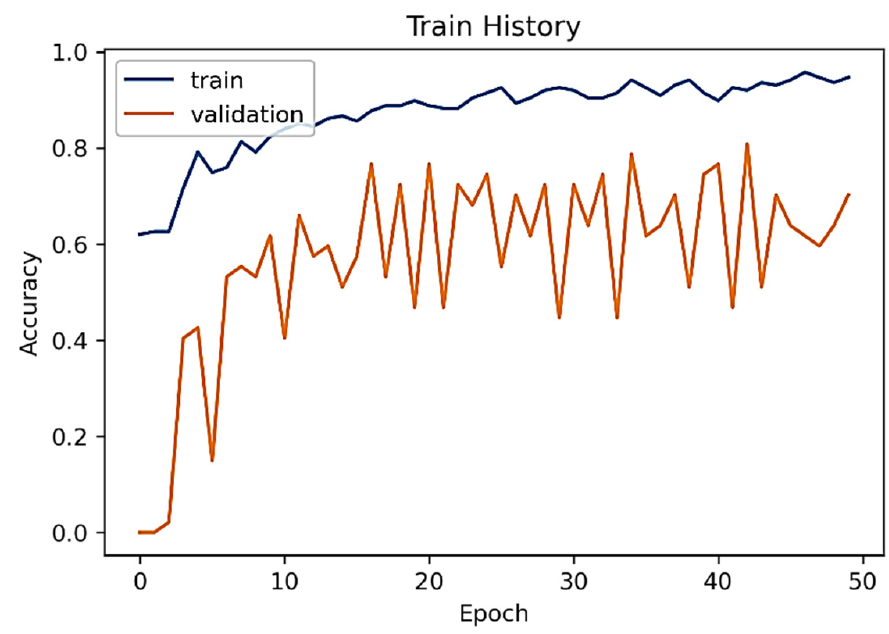
Figure 7. The learning curve of our CNN model with the training set and validation set.